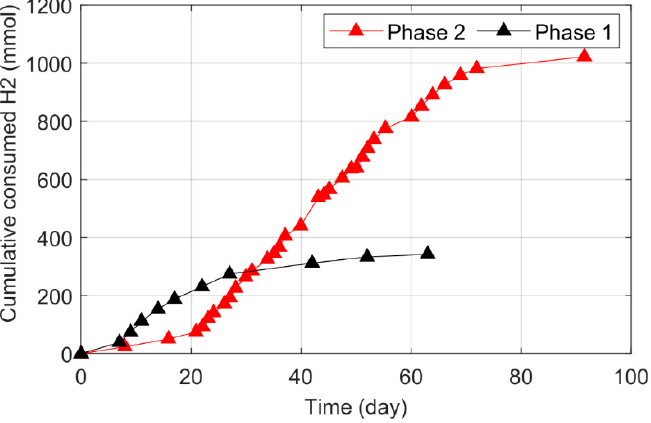
Figure 2. The cumulative hydrogen-consumption profiles for Phases 1 and 2.